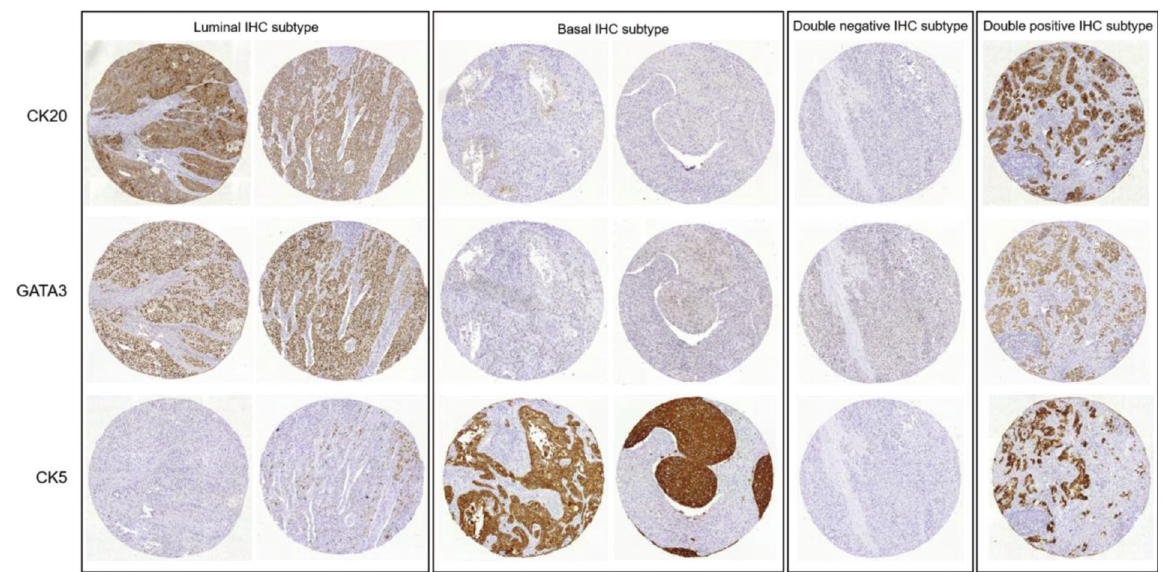
Figure 1 - TMA cores stained with CK20, GATA3 and CK5 showing representative cases grouped as luminal, basal, double-negative and double-positive immunohistochemical subtypes.